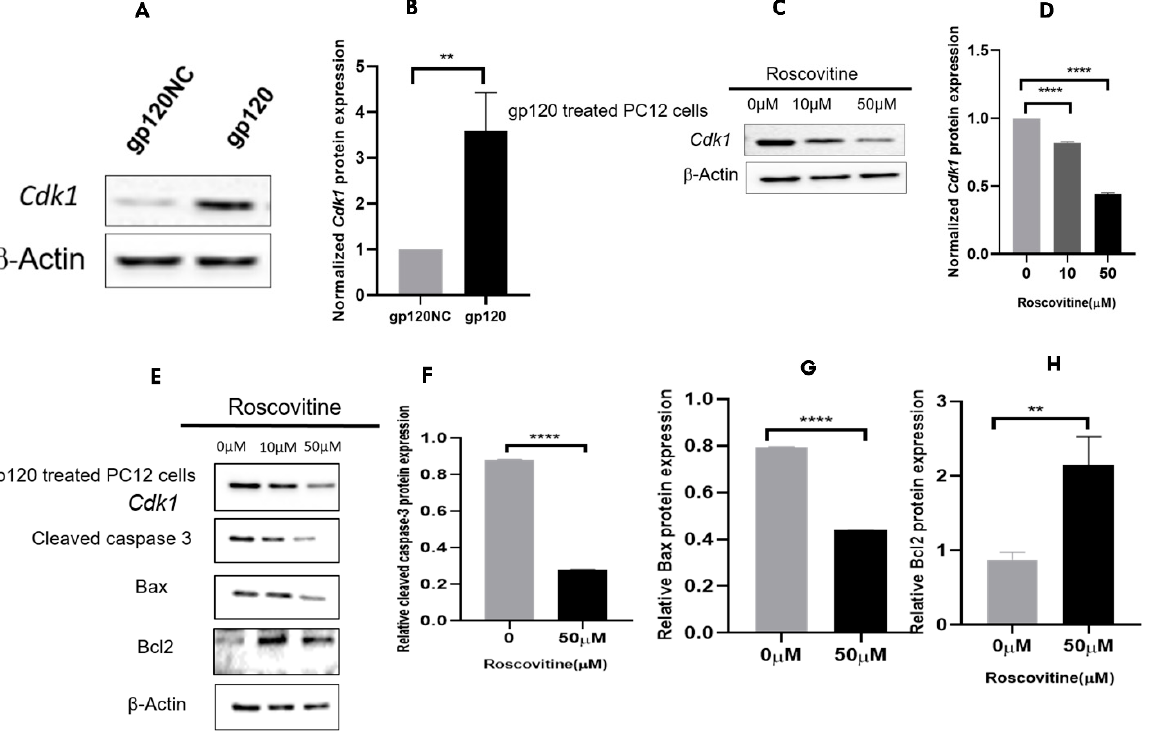
Figure 7. Cdk1 gene expression before and after treatment with a Roscovitine inhibitor. ( A ) Using Western blotting, the Cdk1 protein expression in PC12 cells expressing gp120 was compared to that in untreated cells. ( B ) The gp120 treatment group showed a significant increase in CDK1 protein expression than the untreated group. ( C ) Western blotting shows that Roscovitine inhibits CDK1 protein expression in gp120-expressing cells. ( D ) After 12 h, the administration of Roscovitine dramatically decreased CDK1 expression at the concentration of 50 µM. ( E – H ) Apoptosis-related proteins expression (Cleaved caspase-3, Bax, and Bcl2) in PC12- cells expressing gp120 treated with inhibitor as compared to untreated cells. Each Western blotting was loaded with control, B-Actin, n = 3. t -test, ** p < 0.01, ordinary one-way ANOVA **** p < 0.0001.